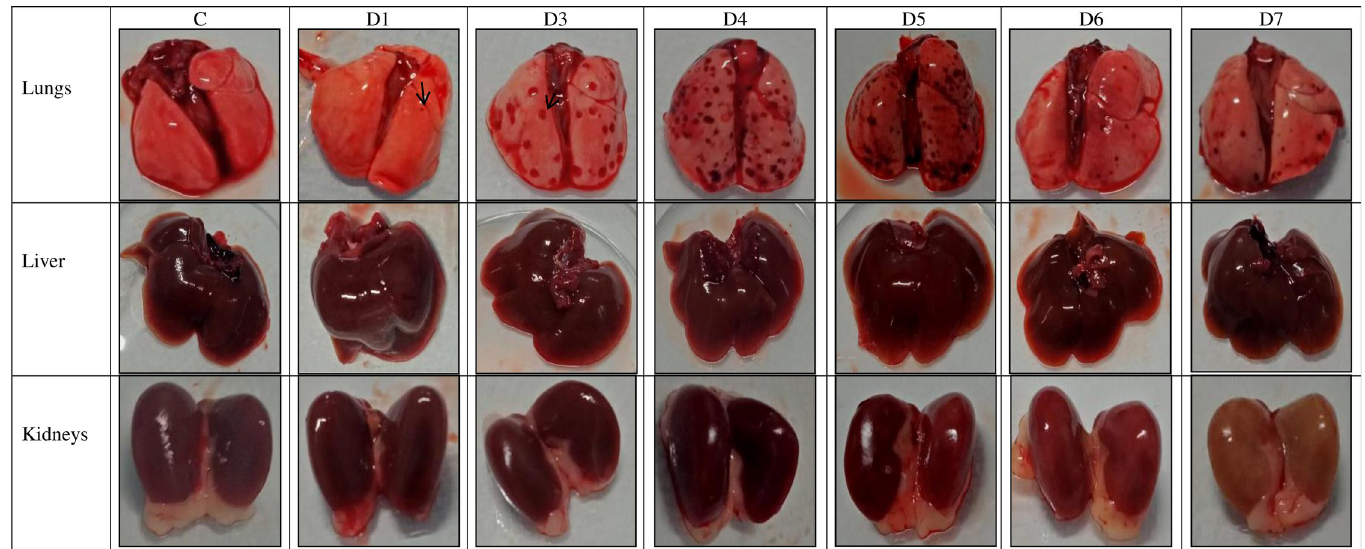
Fig 1. Gross appearance of organs. Petechial haemorrhages were observed in the lungs from day 1 p.i. and became severe from day 3 p.i. onwards. Kidneys became progressively pale from day 6 p.i. onwards. No notable changes were observed in the liver. C: Control; D1-D7: Day 1 to Day 7. The arrow shows a petechial haemorrhage.